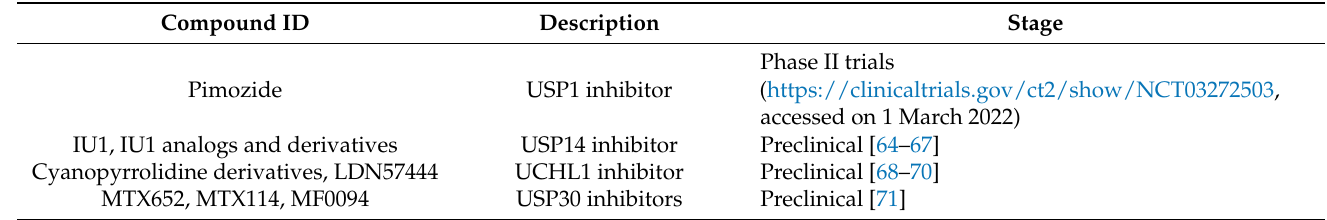
Table 4. Selected DUB small molecule inhibitors reported in neurodegenerative